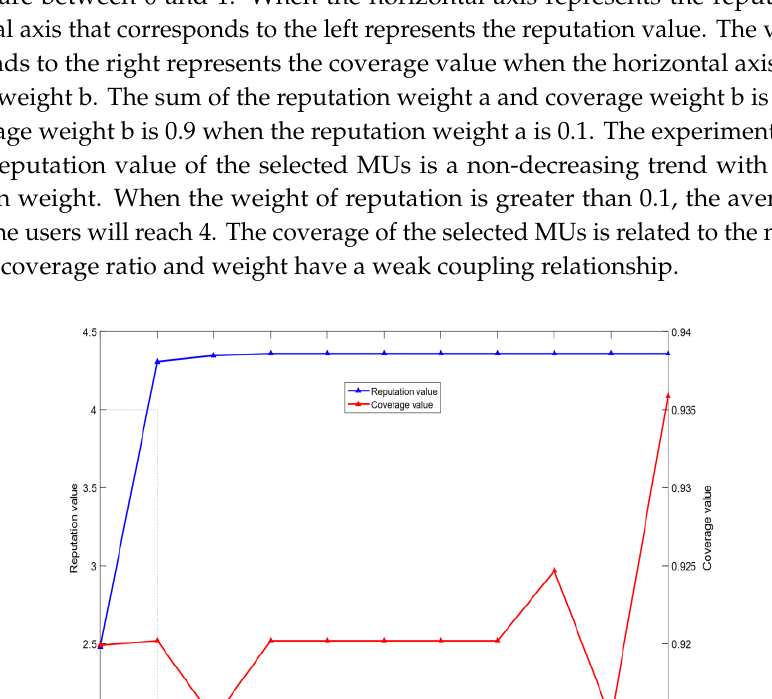
Figure 4. Change of coverage and total reward.